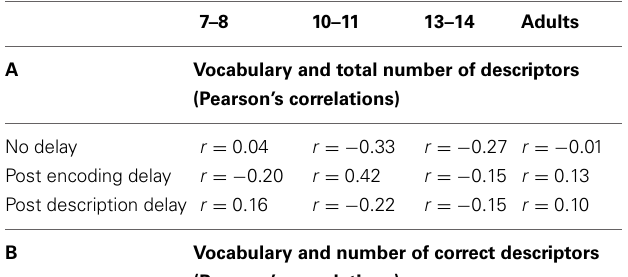
Table 2 | Correlations between performance on the vocabulary task and description quantity (A), description quality (B and C) and identification performance